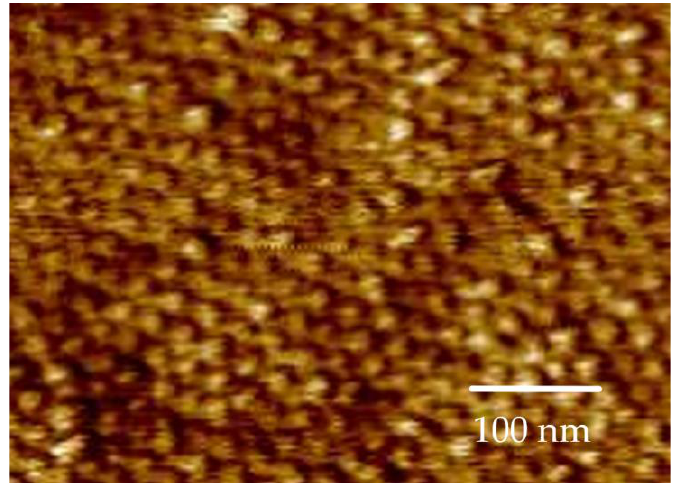
Figure 4. AFM image of cylinders (corresponding to Figure 3 No. 7).